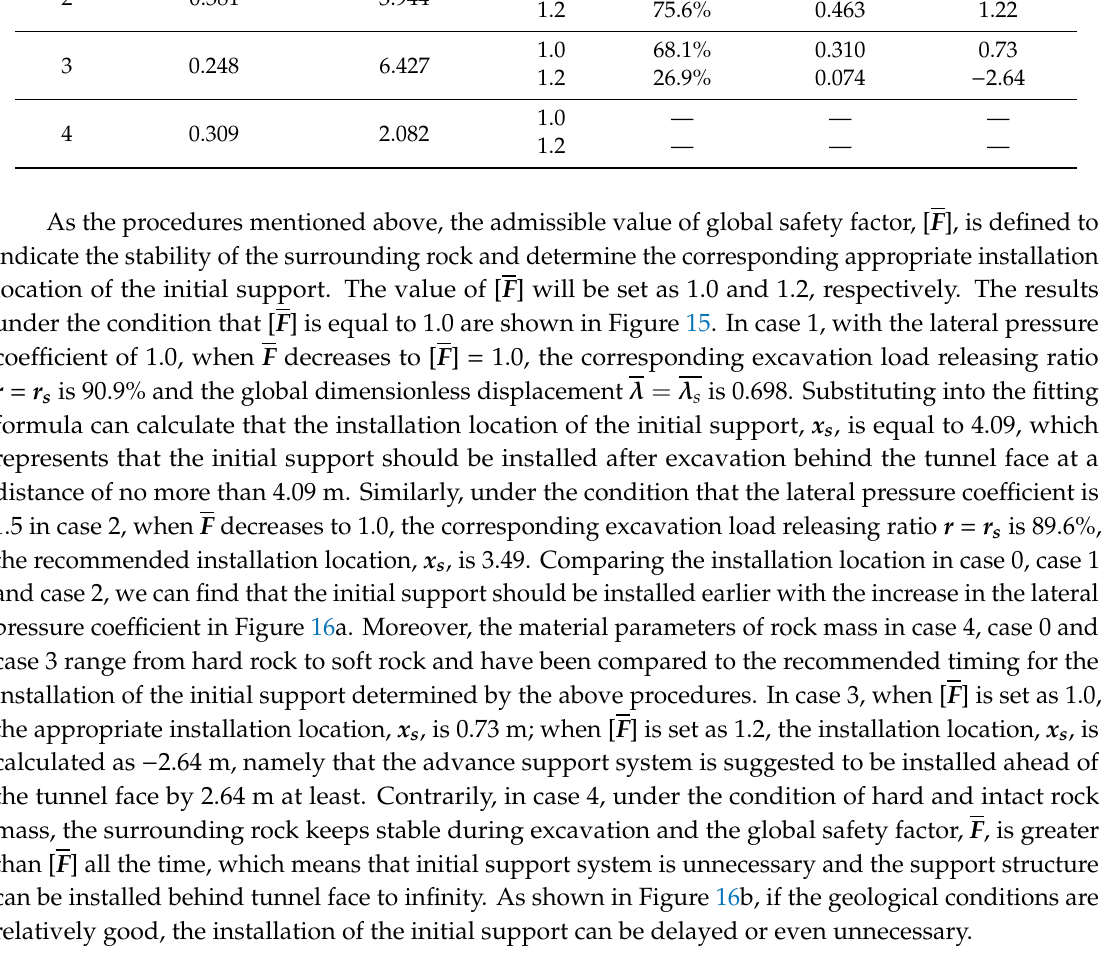
Figure 15. Installation location for the initial support: ( a ) case 1, ( b ) case 2, ( c ) case 3.